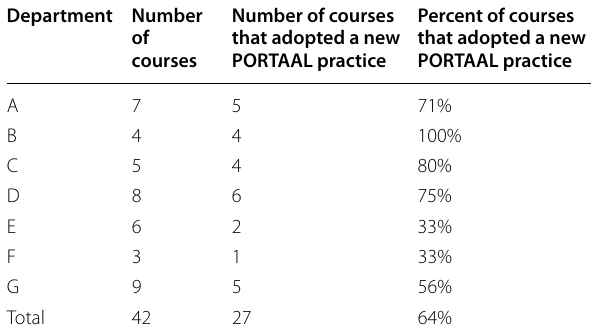
Table 4 Number and percentage of courses per department that adopted at least one new PORTAAL practice